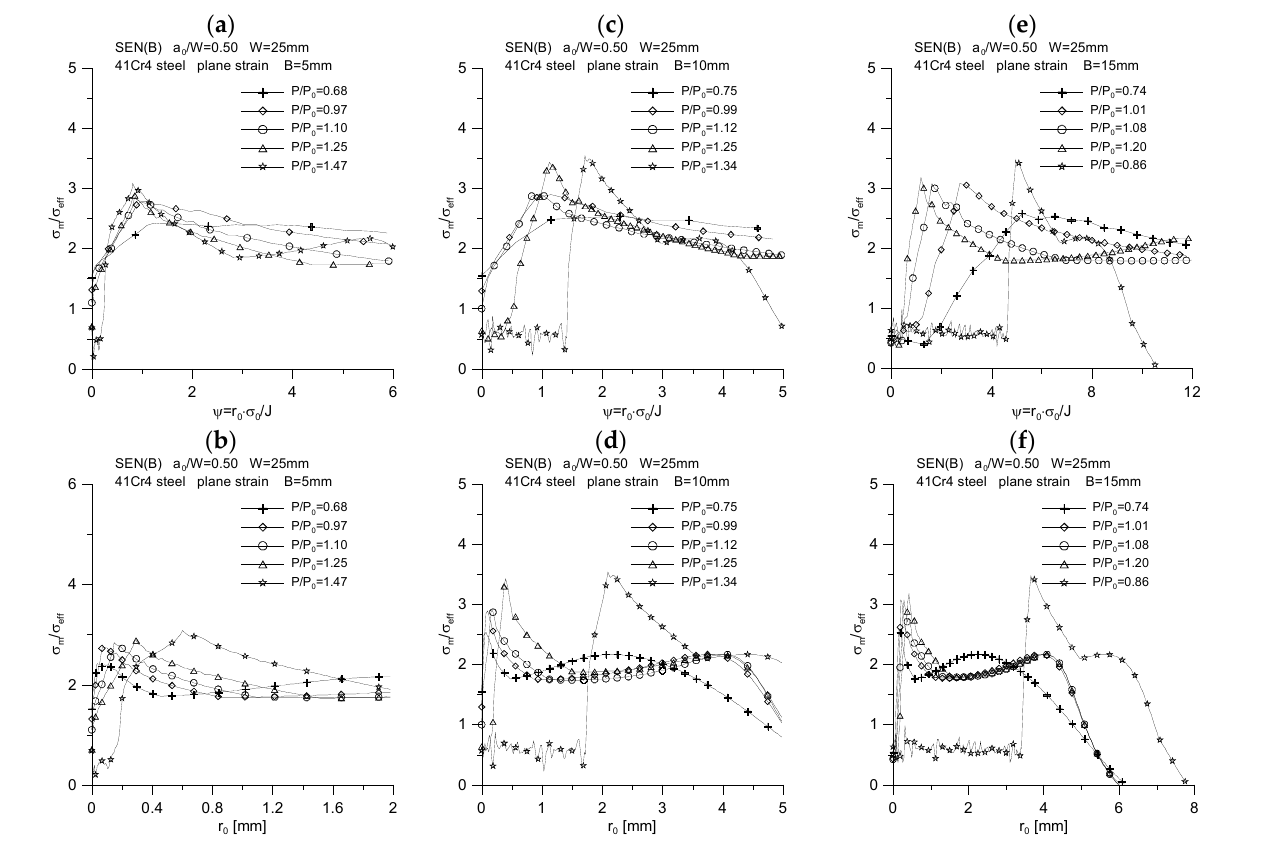
Figure 11. Distribution of the quotient σ m / σ eff for three specimens used in the crack propagation simulation. The graphs ( a , c , e ) were made for the normalized distance from the crack tip, ψ = r 0 · σ 0 / J , while the graphs ( b , d , f ) were prepared for the physical distance from the initial crack tip position, r 0 . The figures show the distributions for the characteristic moments provided in Table 2.